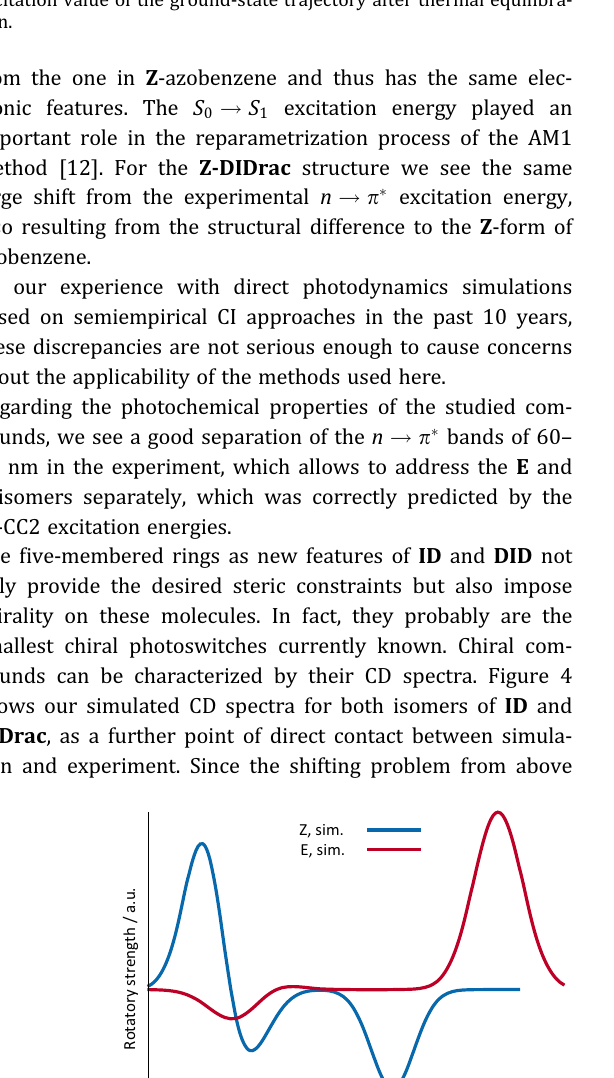
All values in nanometer. a The deviations are the standard deviations from the average vertical excitation value of the ground-state trajectory after thermal equilibra- tion.